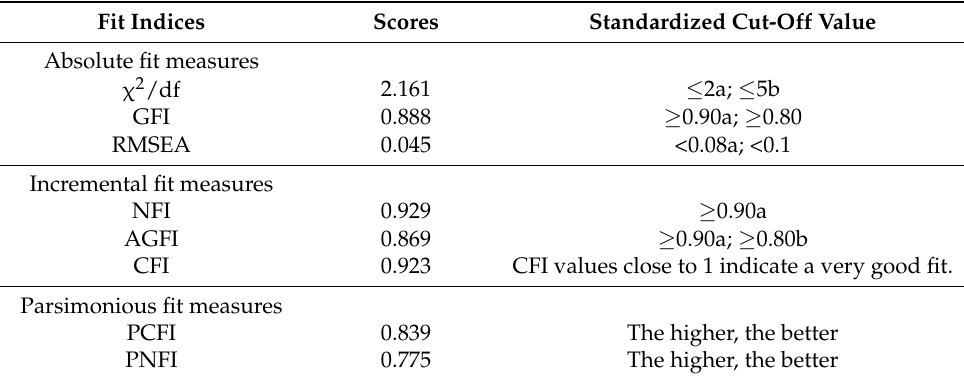
Table 5. CFA results of model fitness for determinants accounting practices and organizational performance.